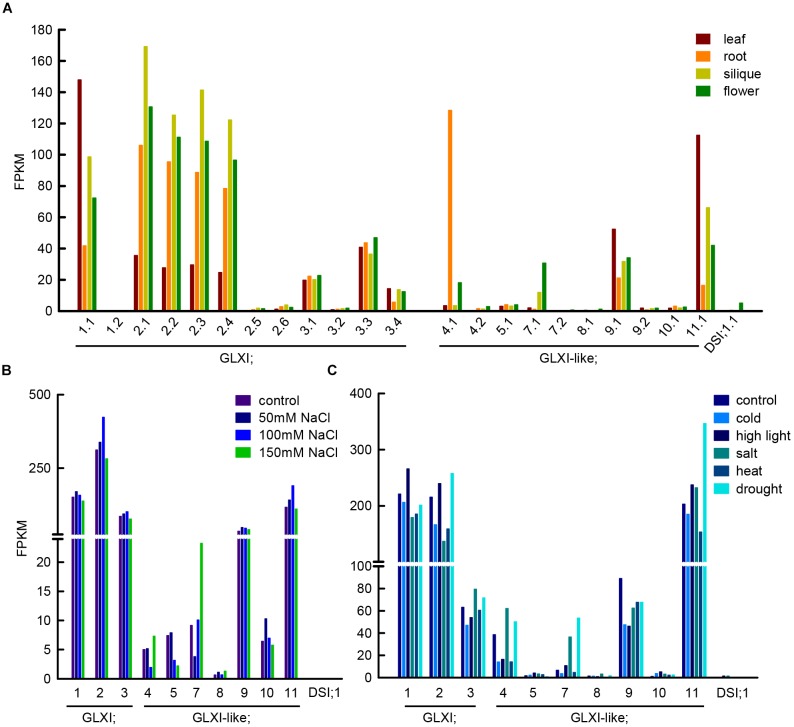
Transcript abundance of GLXI and GLXI-like splice forms and gene expression under abiotic stress conditions. (A) FPKM (fragments per kilo base of exon per million fragments mapped) values of GLXI and GLXI-like splice forms in Arabidopsis leaf, root, siliques, and flowers. Raw data was taken from Liu et al. (2012) (PRJNA168212). (B) GLXI, and GLXI-like transcript abundance in FPKM in 21-days-old Arabidopsis plants after 24 h treatment with 50, 100, and 150 mM NaCl. Raw data taken from Shafi et al. (2015) (PRJNA217812). (C) GLXI, and GLXI-like transcripts in FPKM in whole 12-days-old Arabidopsis seedlings after 24 h of abiotic stress exposure. Raw data taken from Filichkin et al. (2010) (SRA009031). Raw data was re-mapped with high stringency to the TAIR 10 annotation as described in Schmitz et al. (2017).